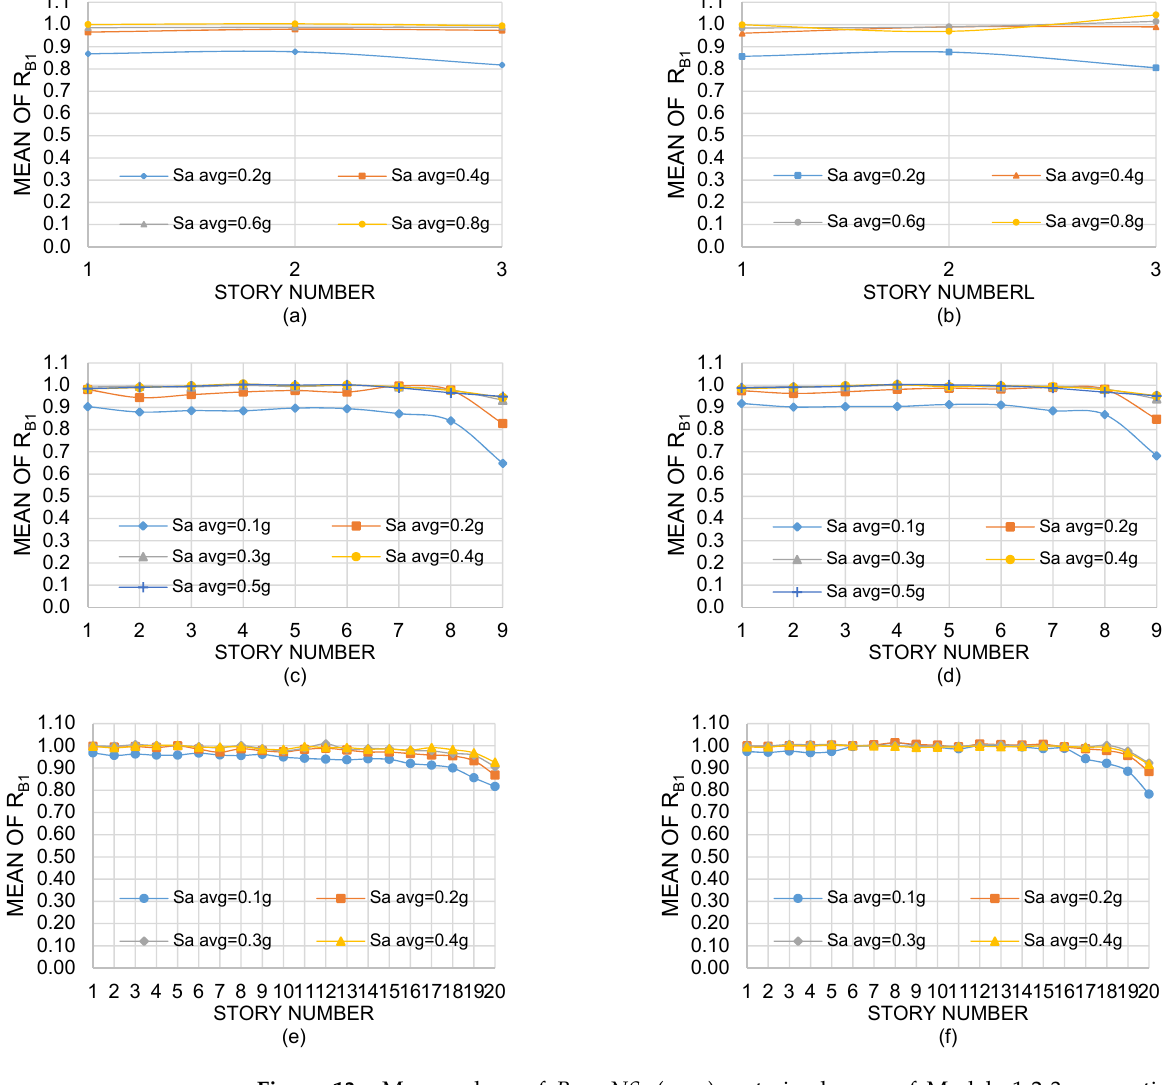
Figure 13. Mean values of R B 1 , NS : ( a , c , e ), exterior beams of Models 1-2-3, respectively; ( b , d , f ), interior beams of Models 1-2-3, respectively.